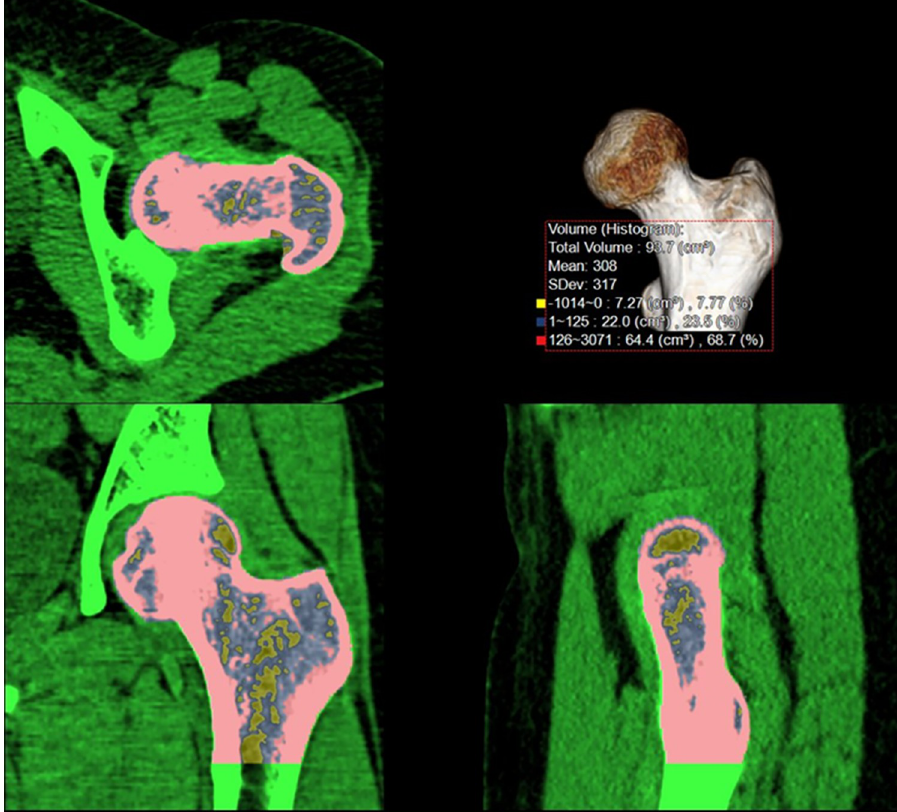
Fig 2. 3D-Femur-VOI measurement. 3D-Femur-VOI is selected using a 3D region-growing editing tool. Femur is selected from head to the inferior margin of lesser